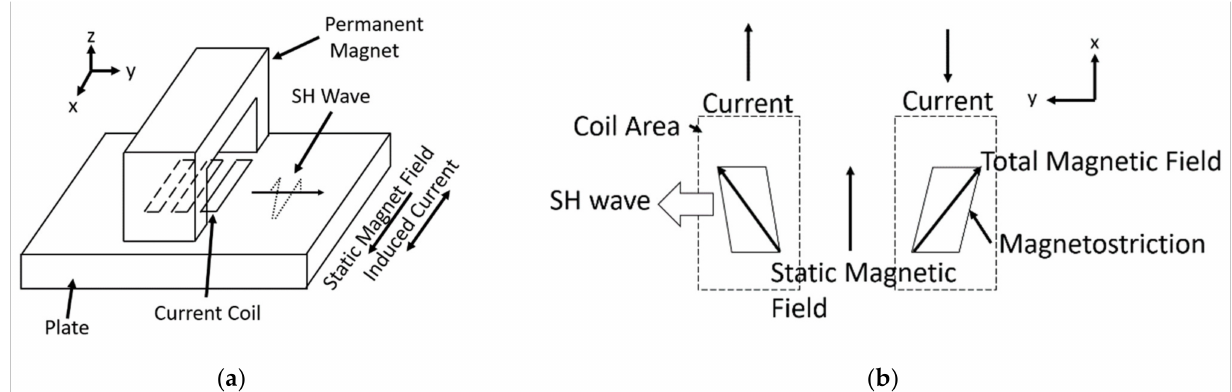
Figure 2. ( a ) Magnetostrictive (MS) EMAT 3D Diagram; ( b ) Top View of the Magnetostriction within the